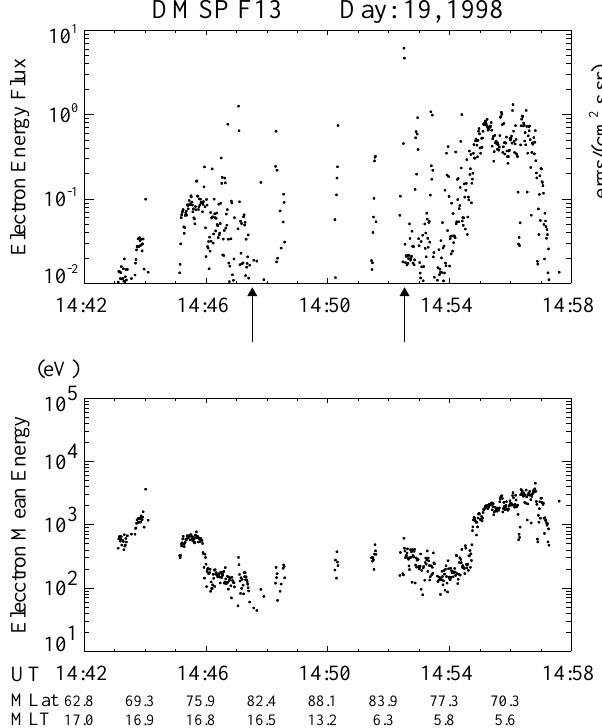
Fig. 4. Similar to Fig. 3, but from 1442 to 1458 UT on January 19, 1998. The polar cap boundaries are identified by two